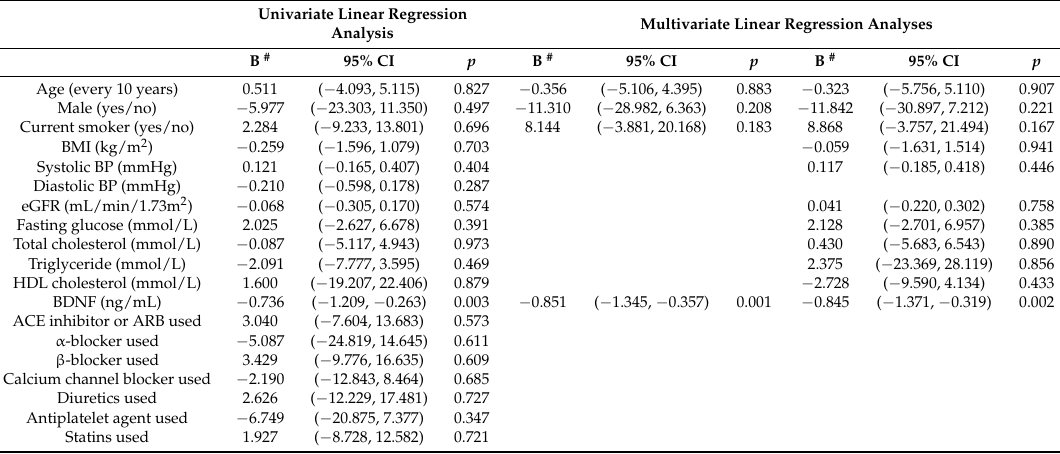
Table 4. Effect of baseline risk factors on the percentage change serum renalase levels after percutaneous coronary intervention (PCI). Univariate Linear Regression Analysis